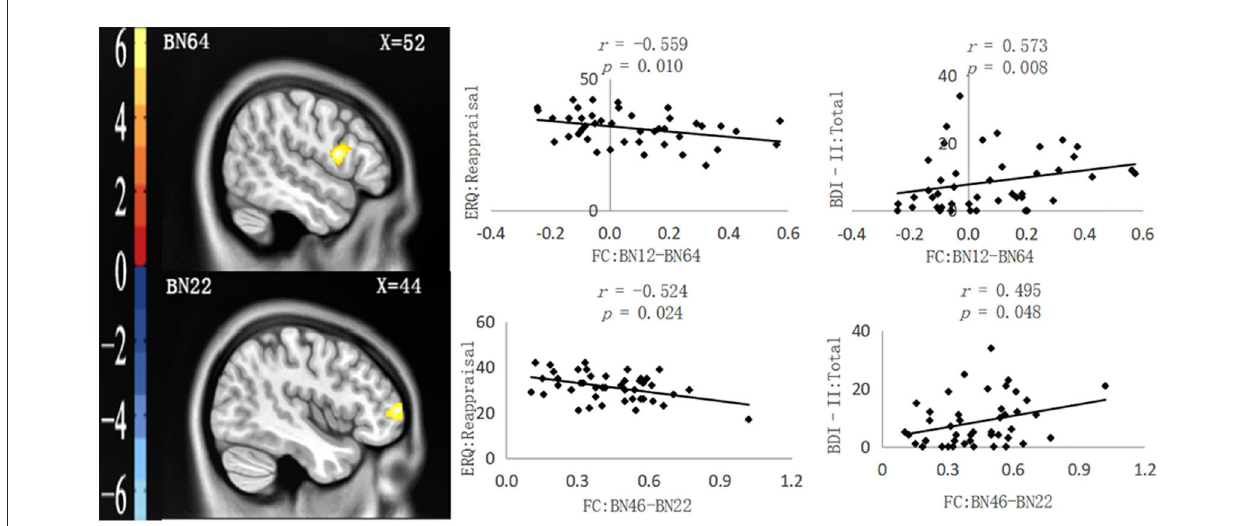
FIGURE2 Functional connections (neglect group > control group) significantly correlated with ERQ: Reappraisal and BDI-II: Total. Left : Brain regions functionally connected with the ROIs. Right : Scatter plot of the correlation between the FC value and ERQ reappraisal and BDI-II: Total. All the p- values underwent Bonferroni corrections.